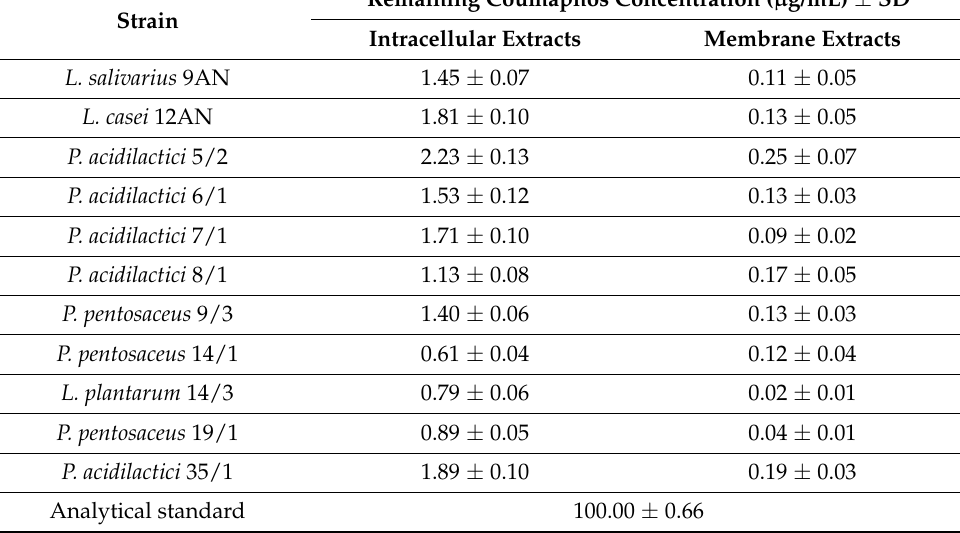
Table 3. Amount of coumaphos bound to intracellular extracts and membrane extracts after 24 h incubation with selected strains of lactic acid bacteria (LAB). The experiments were conducted for whole live LAB cells. The initial concentration of an individual pesticide was 100 µ g/mL. The presented results are mean from two measurements ±